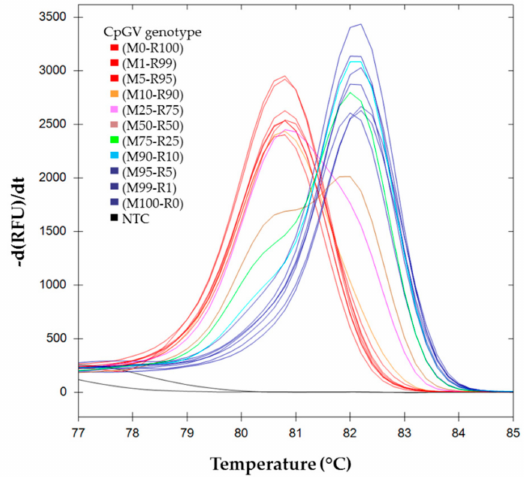
Figure 2. Melting curves analysis of pe38 amplicons in DNA mixture. First derivative of RFU (relative fluorescence unit) depending on temperature are represented for each inoculum mix M i -R j , where M i indicates the relative proportion of CpGV-M and R j indicates the relative proportion of CpGV-R5. ( ) (M0-R100), (M99-R1), (M95-R5); ( ) (M100-R0), (M1-R99) and (M5-R95); ( ) (M90-R10); ( ) (M75-R25); ( ) (M50-R50); ( ) (M25-R75); ( )